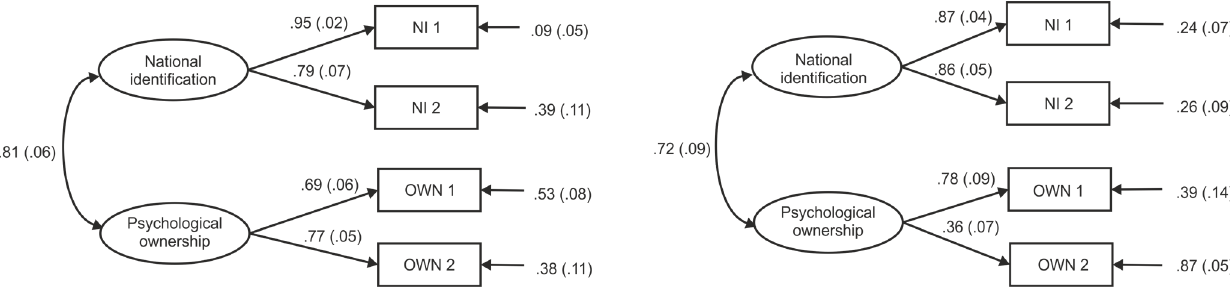
Figure 2. Results of CFA for items measuring national identification and psychological ownership of Finland among majority Finns (left) and Russian immigrants (right). All parameters are significant at p <